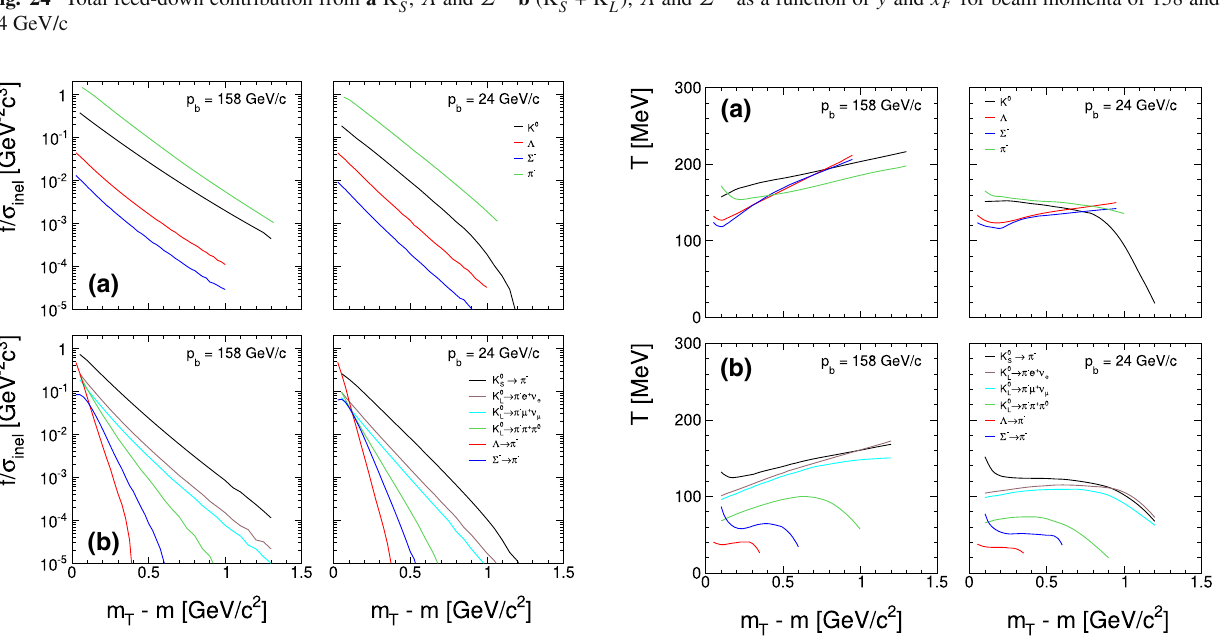
Fig. 24 Total feed-down contribution from a K 0